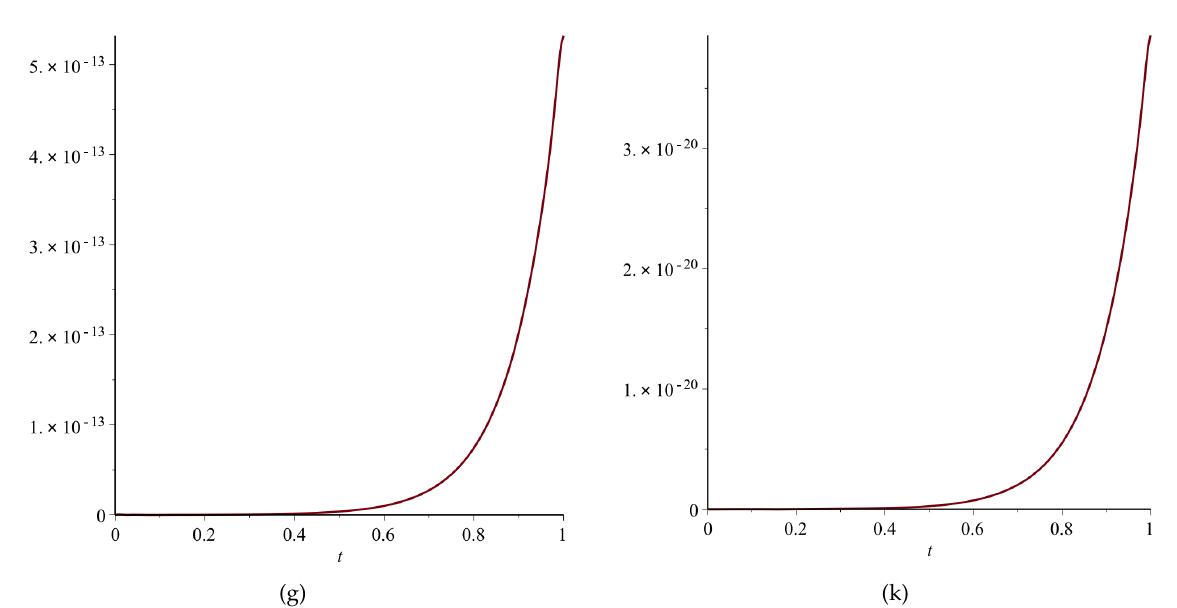
Fig. 4. The absolute errors | e N ( t ) | of the approximate solutions u ( t ) , for (g) n = 20 and (k) n = 40 with a 0 = 20, b 0 = − 10 of Example